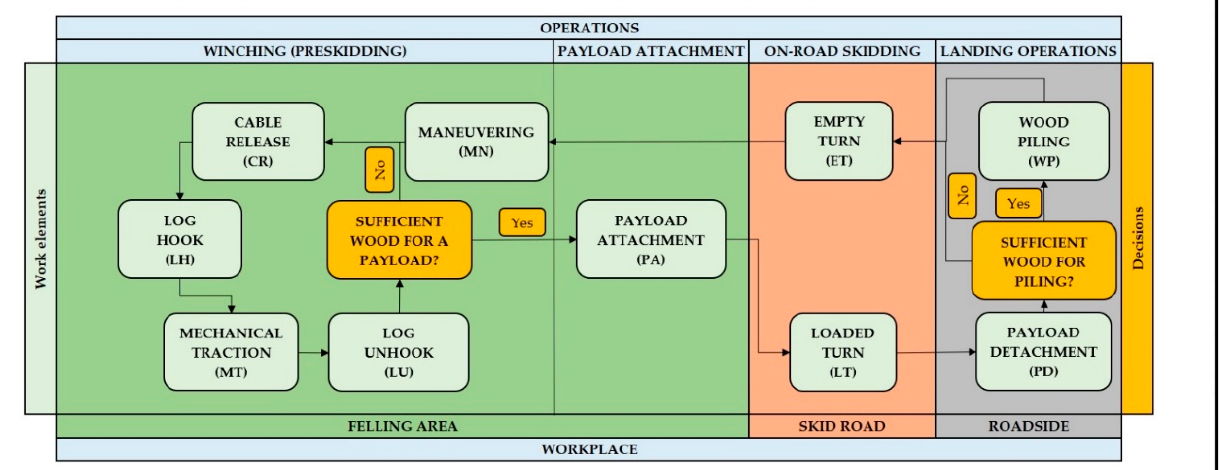
Table 2. Description of the tractor and winch used in both forest compartments.